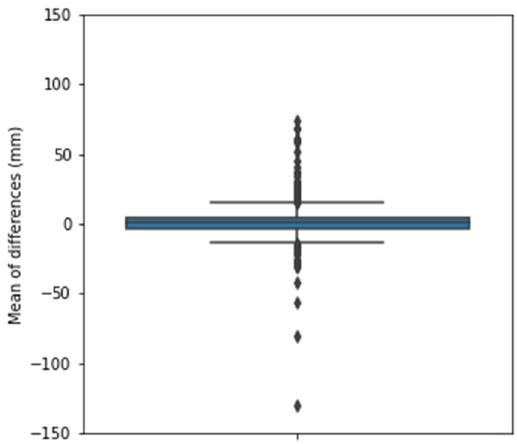
Figure 2: Boxplot of the mean of di ff erences between SIRGAS - CON ZTD and ERA5 ZTD for each station.